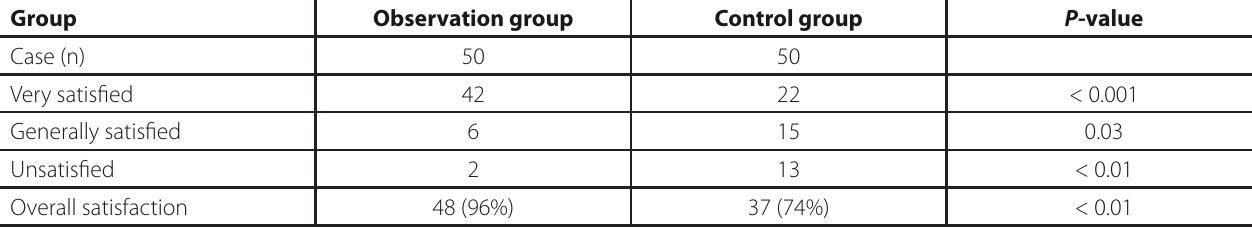
Table 5. Comparison of nursing satisfaction between the two groups after continuing care.